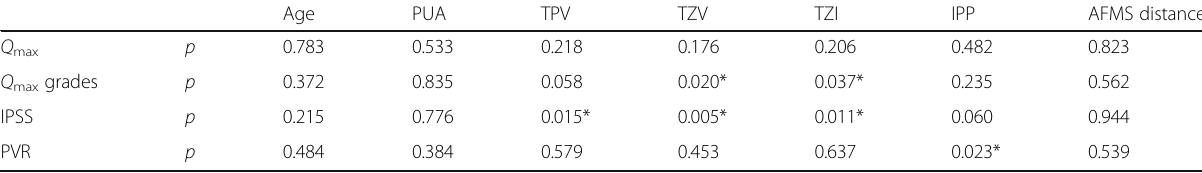
Table 3 Parameters for multiple linear regression between Q max , Q max grades, IPSS, PVR and age, PUA, TPV, TZV, TZI, IPP, AFMS distance